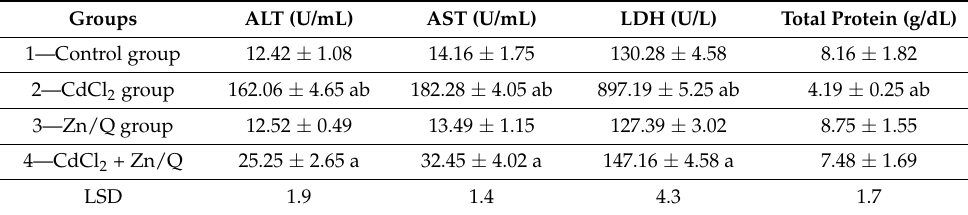
Table 2. Hepatic enzymes of treated groups with CdCl 2 , Q/Zn, and their combinations. Groups